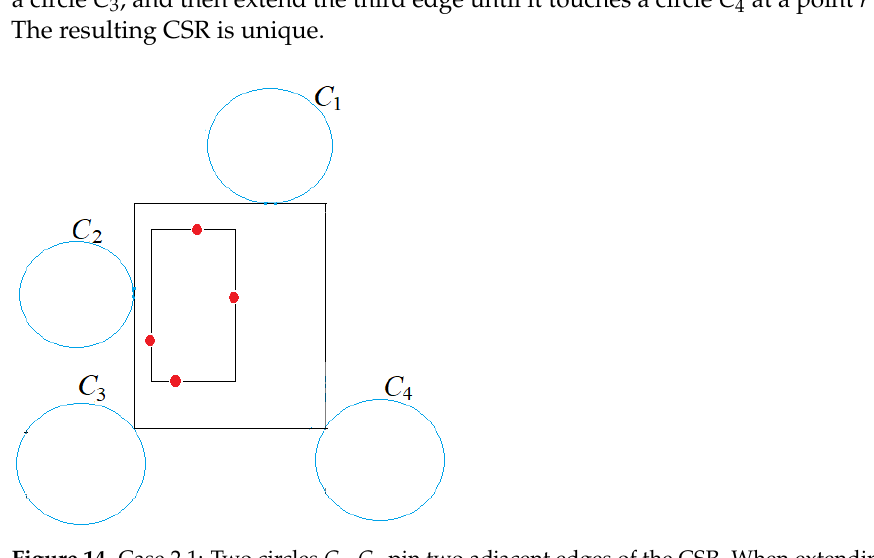
Figure 14. Case 2.1: Two circles C 1 , C 2 pin two adjacent edges of the CSR. When extending one of the edges until it touches a circle C 3 , the resulting CSR is